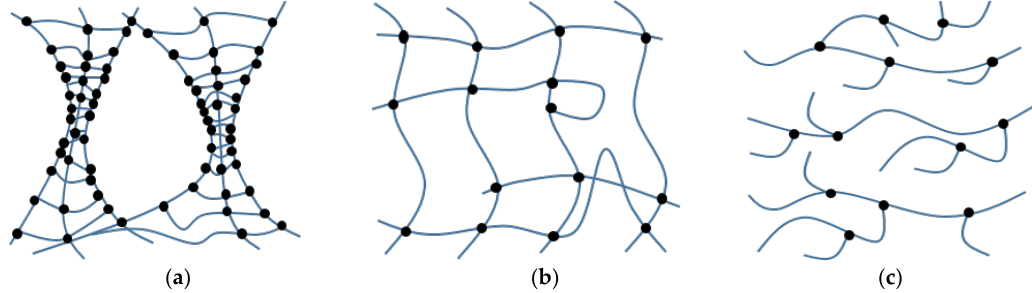
Figure 1. Depiction of some possible frozen inhomogeneities often found in polymer gels: ( a ) spatial inhomogeneities, ( b ) topological inhomogeneities, and ( c ) connectivity inhomogeneities (scheme adapted from [24] with the publisher ’s permission).